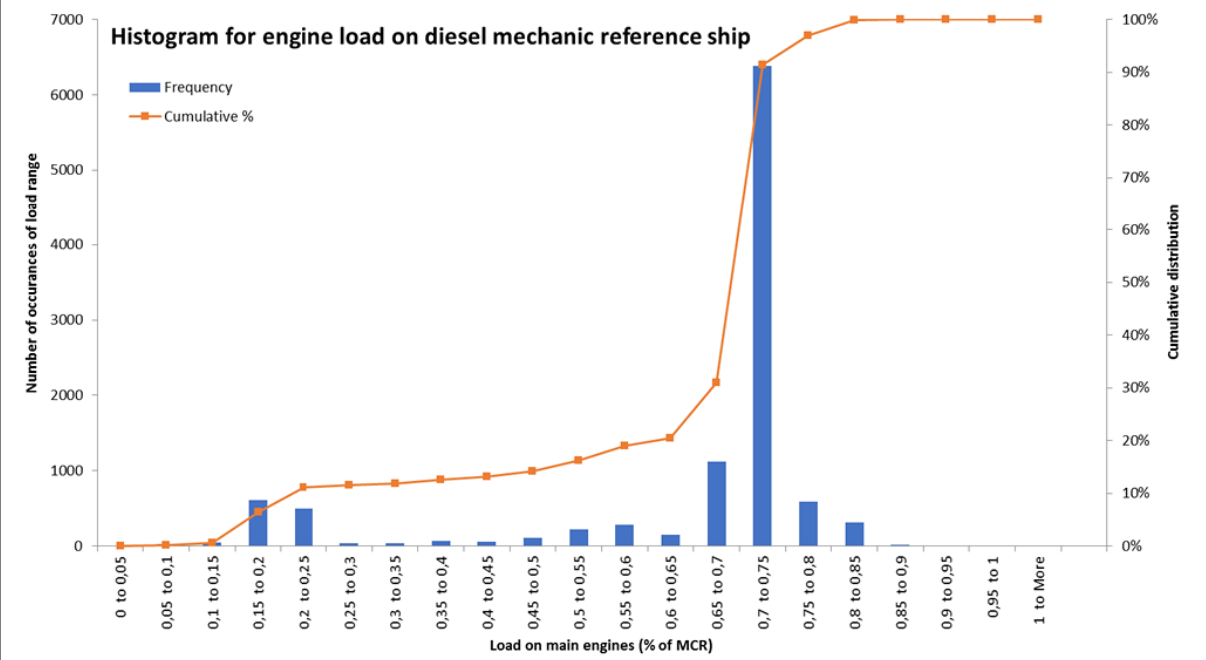
Figure 7. Case study vessel load